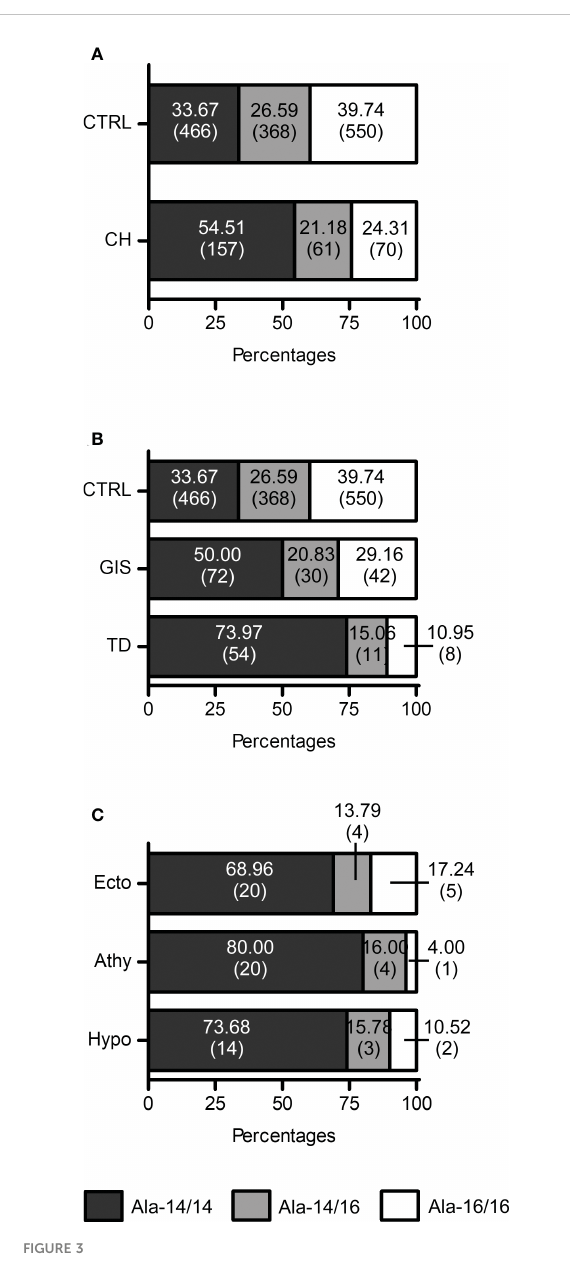
FIGURE 3 FOXE1 polyalanine genotypes distribution indicates a role of Ala-14/ 14 in CH and TD. (A) Graphical representation of the distribution of the Ala-14/14, Ala-14/16 and Ala16/16 FOXE1 genotypes among control group (CTRL) (n=1384) and CH cases (n=288); (B) graphical representation of FOXE1 main genotypes distribution among control group (n=1384), GIS (n=144) and TD (n=73) cases. (C) graphical representation of FOXE1 main genotypes distribution among TD subgroups (Ecto, ectopy, n=29; Athy, athyreosis n=25, Hypo, hypoplasia, n=19). Contingency was evaluated by Chi-square, Chi- square test for trend and Fisher ’ s exact test and is reported in the results and discussion section of the article. CH mut, patients with mutations in CH